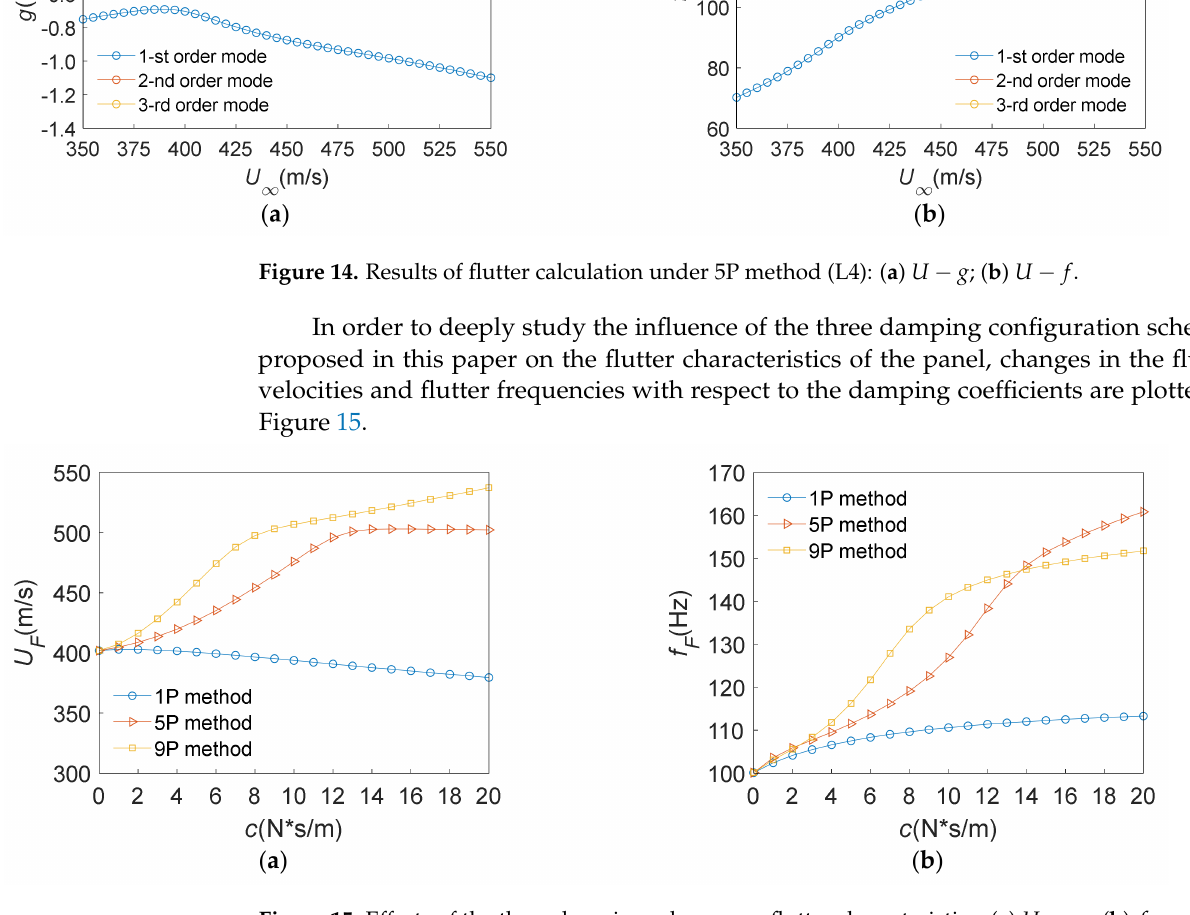
Figure 15. Effects of the three damping schemes on flutter characteristics: ( a ) U F − g ; ( b ) f F − c